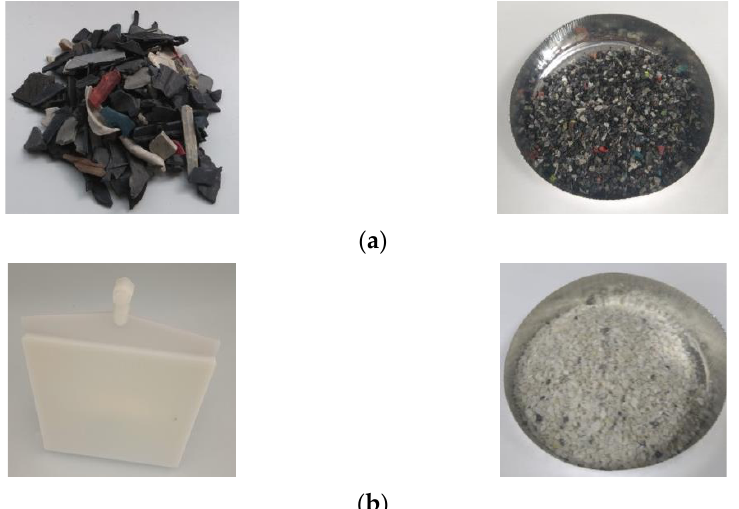
Figure 1. WEEE plastics ( a ) and ABS from WEEE sorting ( b )-based wastes before and after grinding. Table 1. Absolute density of materials.